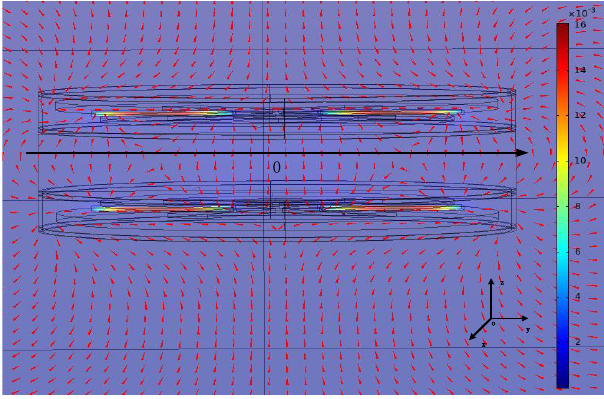
Figure 6. yoz plane magnetic field distribution map .